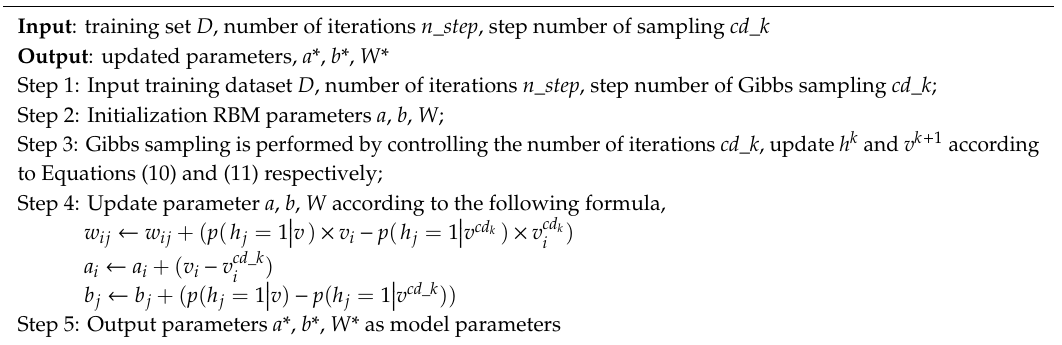
Algorithm 1 Training update for RBM over ( h , v ) based on